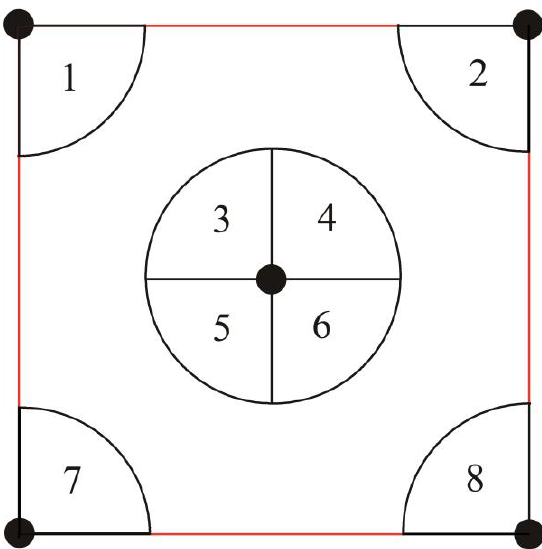
Figure 5. Schematic diagram of Leaf Area Index (LAI) field measurement scheme. The red line is the boundary of the sample plot, the black spot is the measuring station and the fan-shaped area is the orientation of LAI-2200 canopy analyzer probe rod.